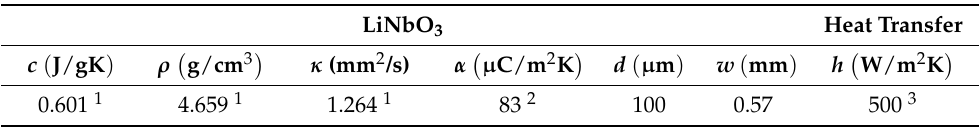
Figure 3. (a) Schematic drawing of temperature distribution in the single-layer model heated with a modulated light in heat exchange gas. The distribution is assumed to be a single damped wave with a time-independent temperature shift by omitting the presence of a reverse wave. (b) and (c) The magnitude of pyroelectricity and the phase shift from the oscillation of the irradiated light calculated using the single-layer model. The physical parameters of LiNbO 3 used in the calculation are listed in Table 1. Table 1. Physical quantities for LiNbO 3 and heat transfer coefficient between He gas and the sample used in the